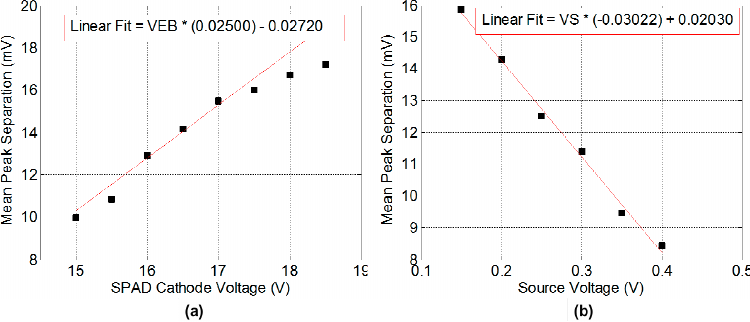
Figure 4. Measured mean peak separation from a set of PCHs, ( a ) The relationship of counter sensitivity sensitivity to SPAD operating voltage; ( b ) The relationship to CTA V SOURCE voltage. to SPAD operating voltage; ( b ) The relationship to CTA V SOURCE